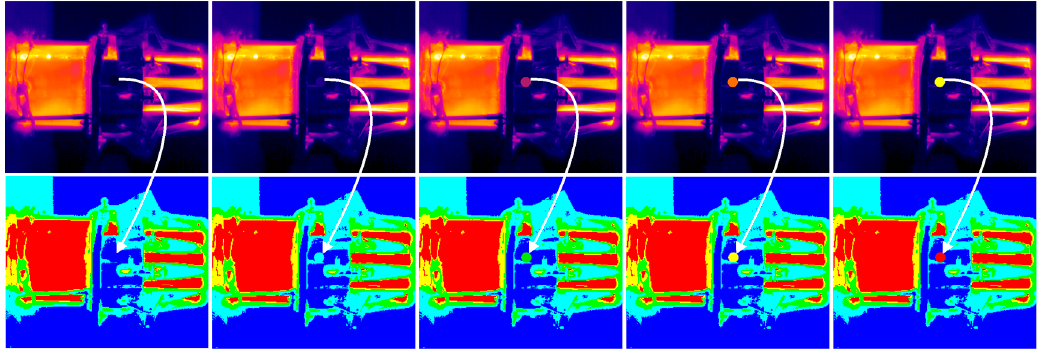
Figure 17. Thermal anomalies correctly classified by the Kohonen network.